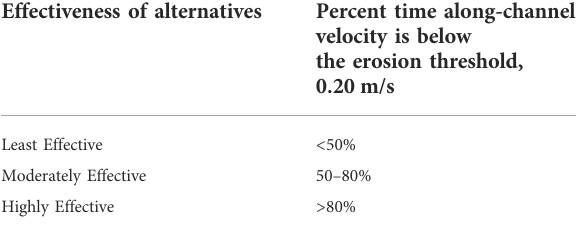
TABLE 3 Effectiveness categories for coastal protection alternatives based on percent duration below the erosion threshold. Effectiveness of